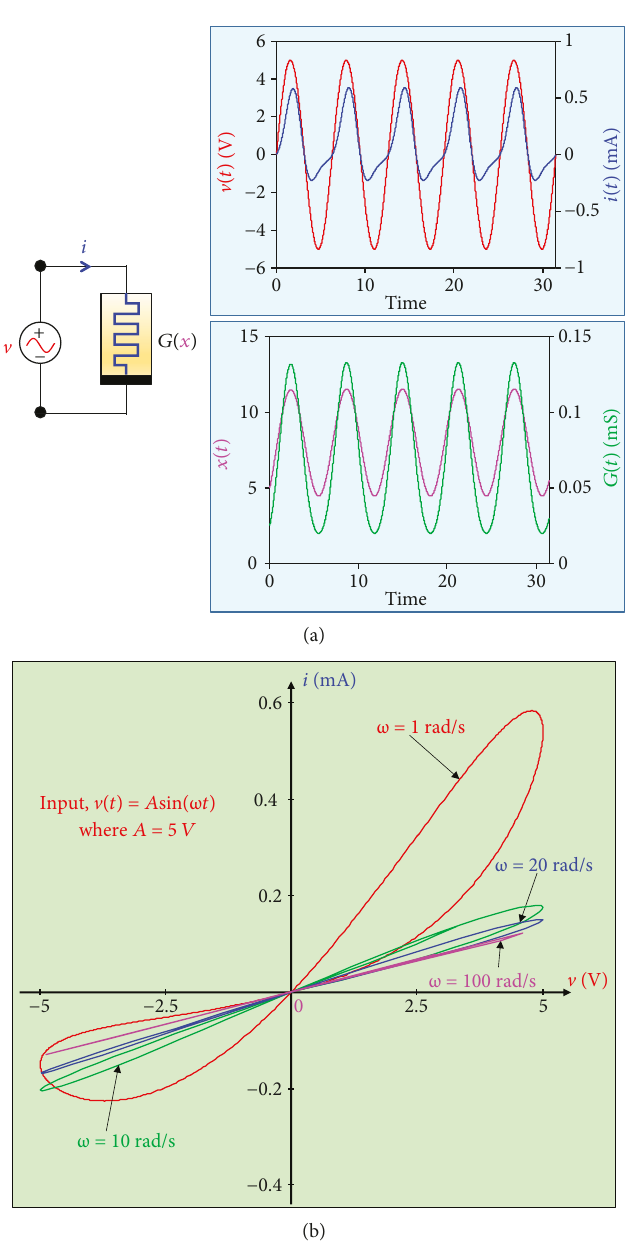
Figure 1: Frequency-dependent pinched hysteresis loop fi ngerprint of the 6-lobe Chua corsage memristor, calculated with initial state x (0) =5: (a) the input voltage v ( t ) (in red), corresponding memristor current i ( t ) (in blue), memristor state x ( t ) (in magenta), and memconductance G ( t ) (in green) of the 6-lobe Chua corsage memristor; (b) frequency-dependent pinched hysteresis loops for zero-mean periodic input v ( t ) = A sin( ω t ) where A =5V and frequency ω =1 rad/s, 10rad/s, 20rad/s, and